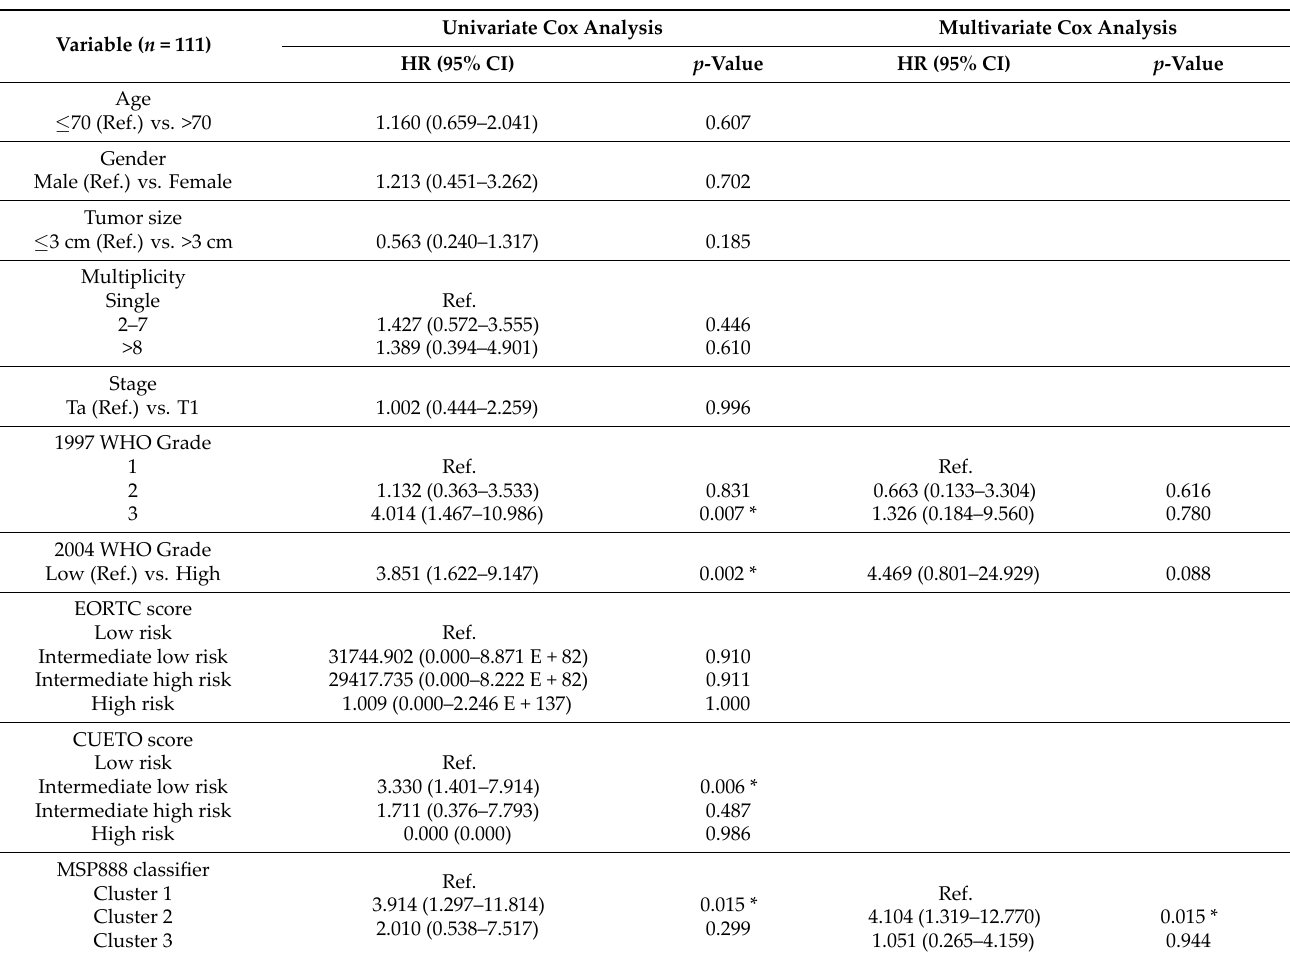
Table 2. Univariate and multivariate Cox regression analyses to predict recurrence of NMIBC pa‑ tients in the CBNUH cohort not treated with